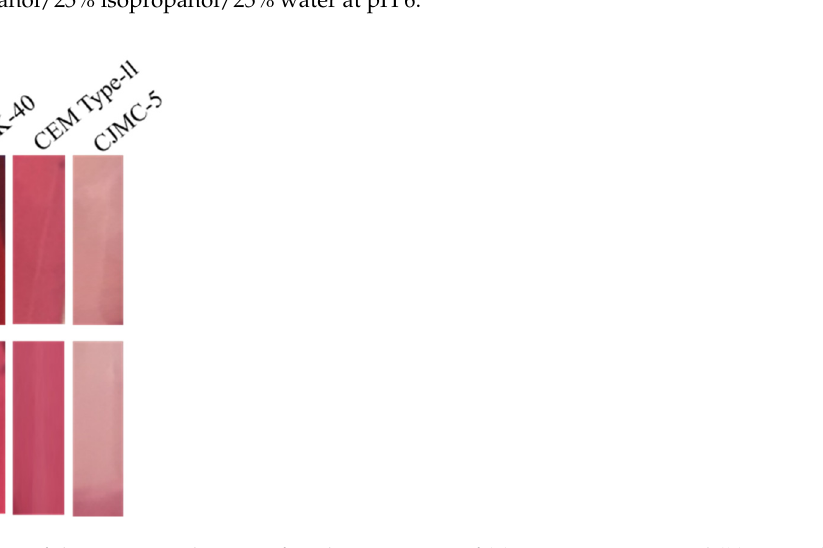
Figure 9. Photos of entire membranes before ( a1 – a4 ) and after ( b1 – b4 ) treatment in 25% acetonitrile/25% methanol/25% isopropanol/25% water at pH 6.